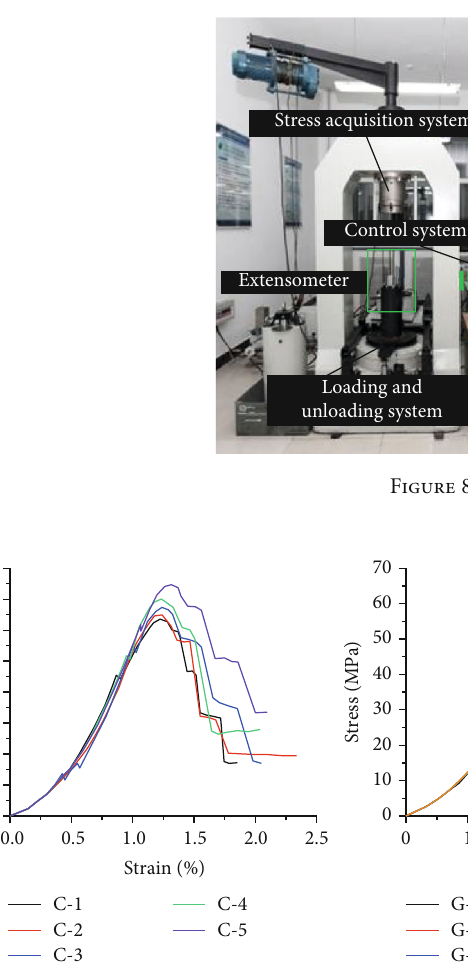
Figure 9: The stress-strain curves of the three test pieces. Table 1: The average of the experimental data.